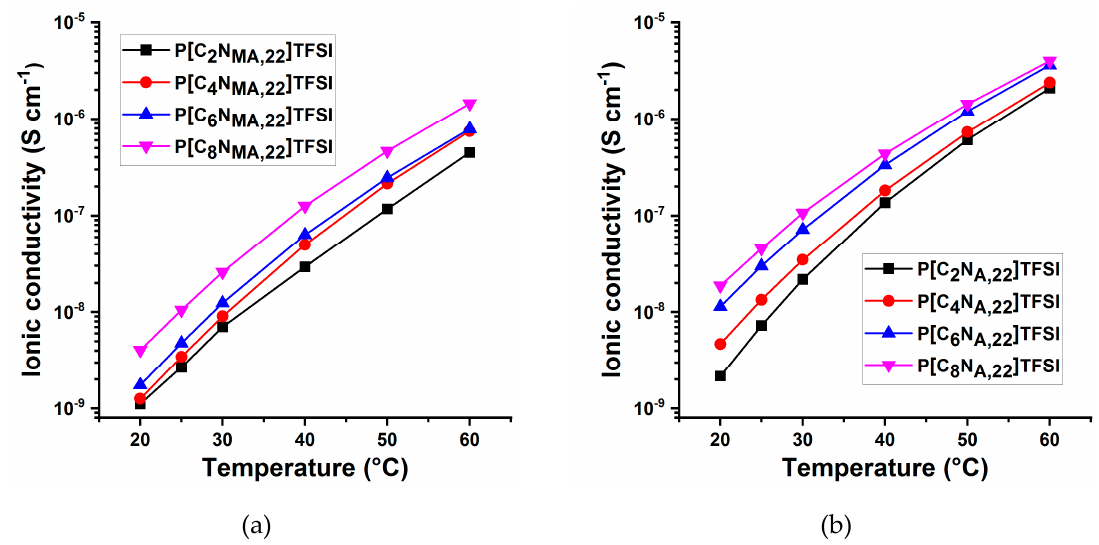
Figure 4. Ionic conductivities of the neat ( a ) methacrylate PIL ( b ) acrylate PIL membranes at various temperatures.